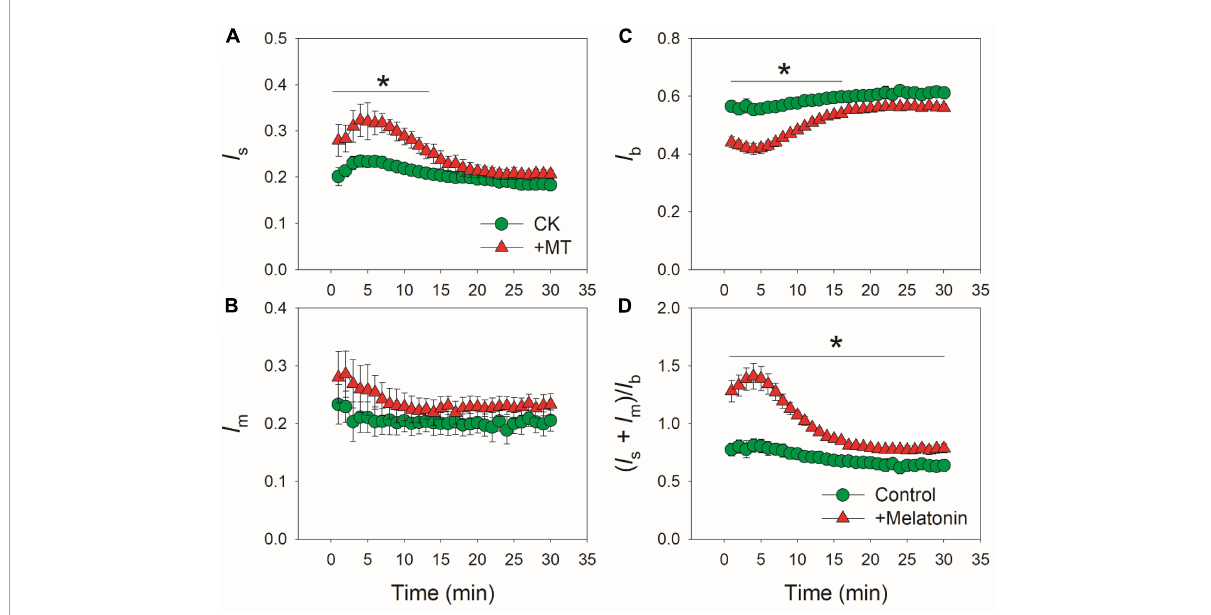
FIGURE4 Effects of exogenous melatonin (MT, 100 µ M) on the induction response of the relative limitations of gs [ls, (A) ], gm [lm, (B) ], biochemical factors [lb, (C) ] and the ratio of (ls + lm)/lb (D) imposed to photosynthesis after transition from 50 to 1500 µ mol photons m − 2 s − 1 . Values are means ± SE ( n = 5). Asterisk indicates a significant difference between CK and MT-treated leaves.